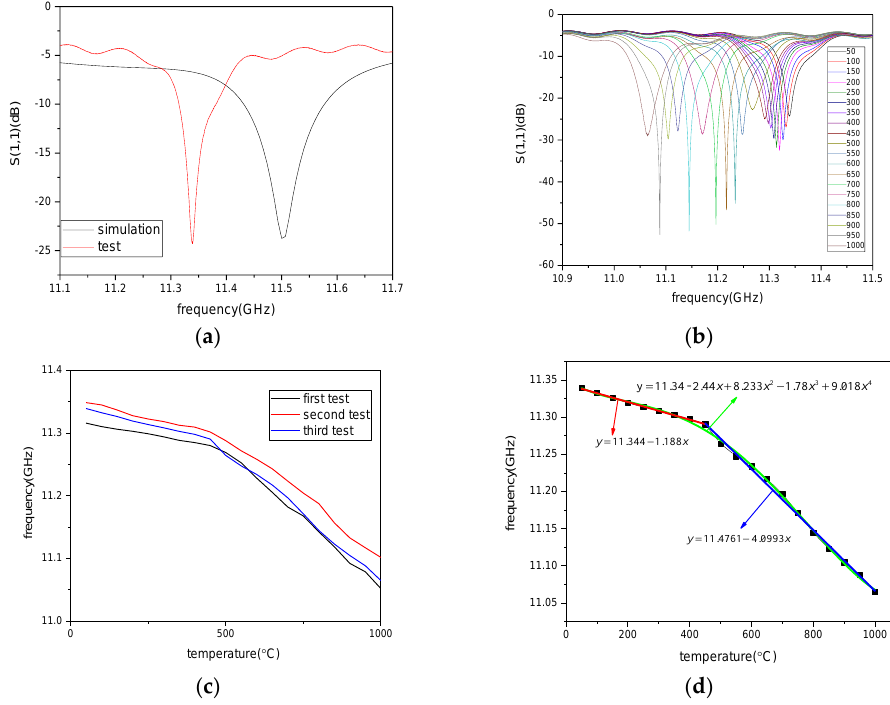
Figure 9. ( a ) Comparison of simulation and test at room temperature, ( b ) Resonant frequency curve of the sensor at different temperatures tested, ( c ) Repeat of temperature test results, ( d ) Quaternary polynomial fitting curve and Piecewise linear fitting curve of high temperature sensor resonant frequency variation curve with temperature.